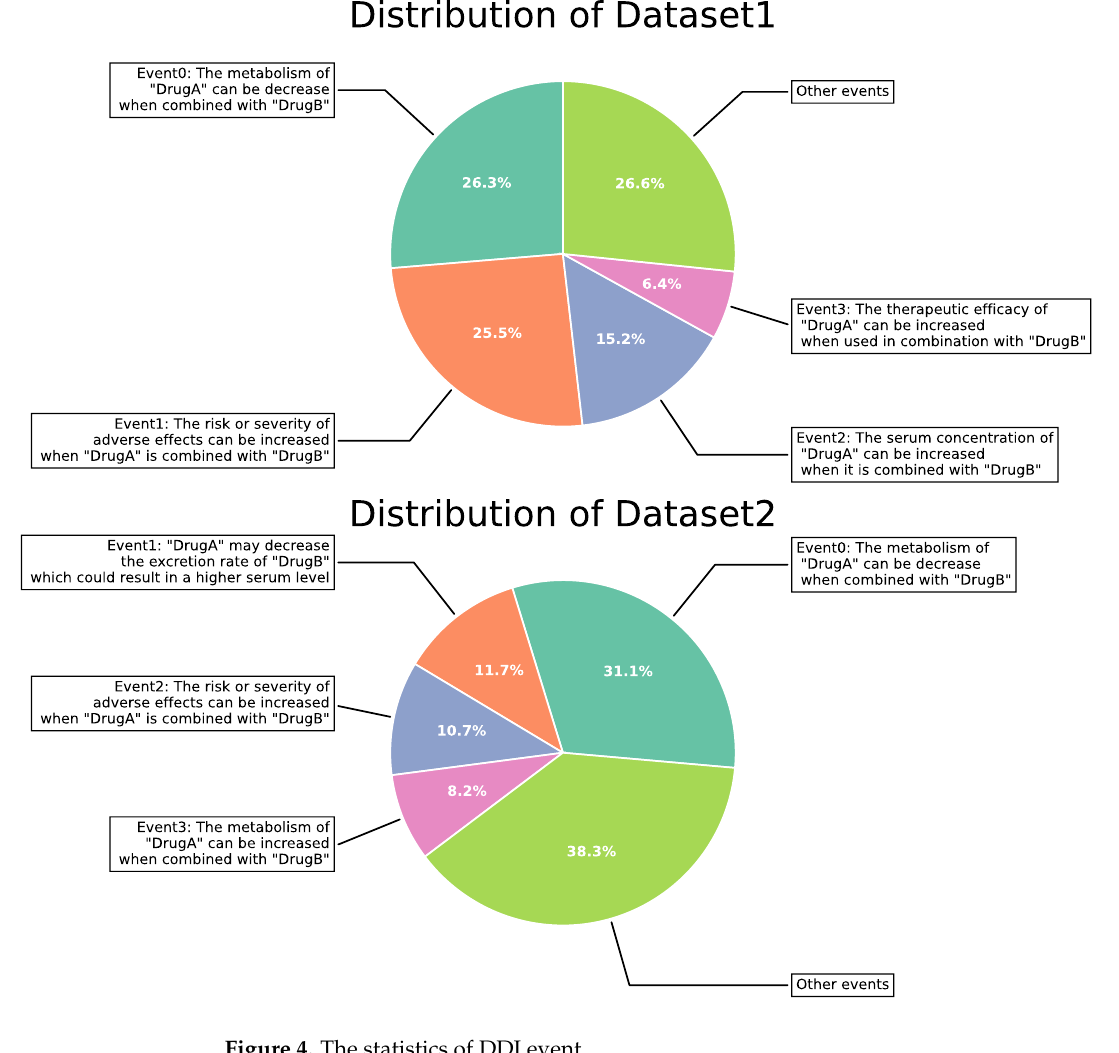
Figure 4. The statistics of DDI event.